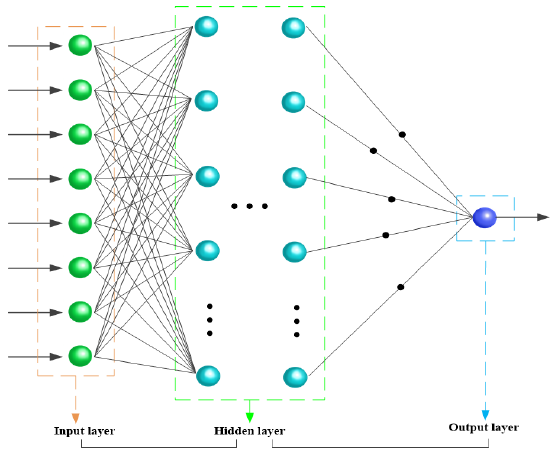
Figure 1. BP neural network topology structure.